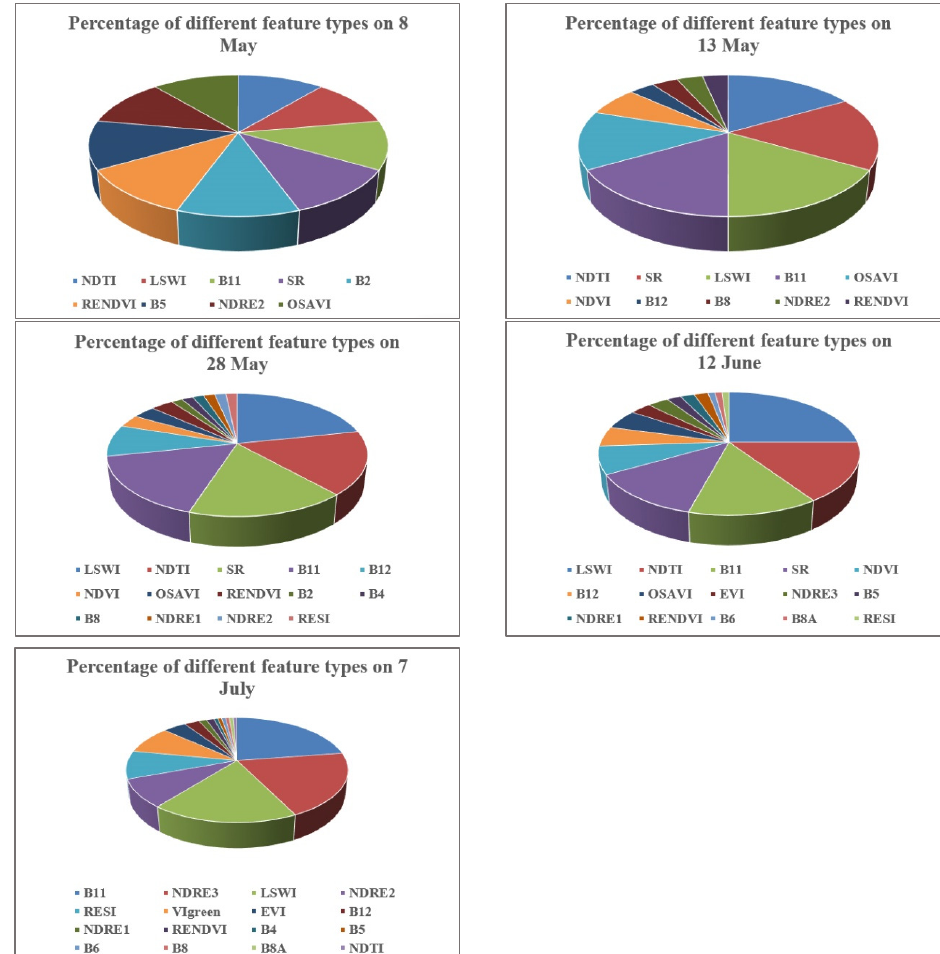
Figure 10. Percentage of different character types of corn in 2020 different periods.